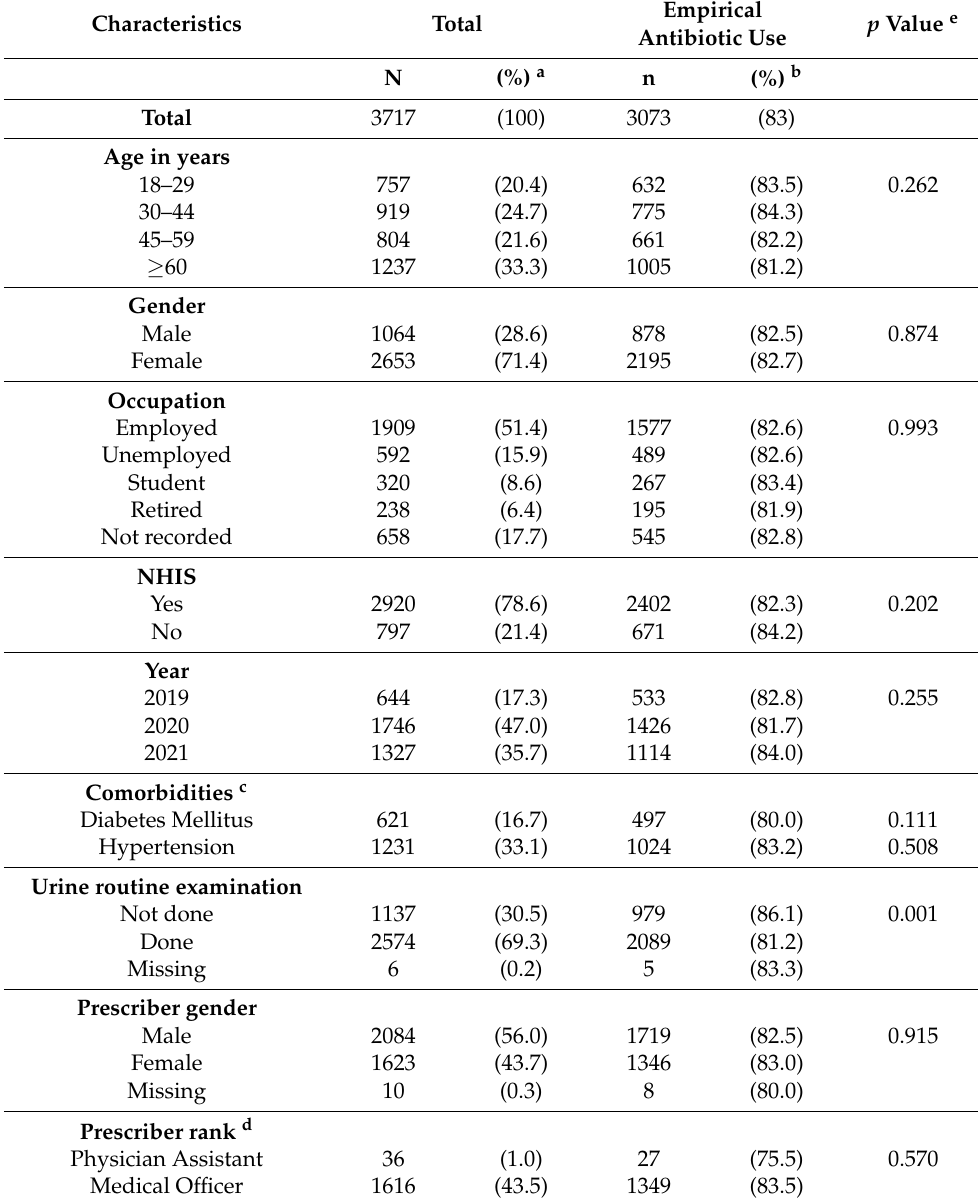
Table 1. Socio-demographic and clinical characteristics of adults with uncomplicated UTIs in